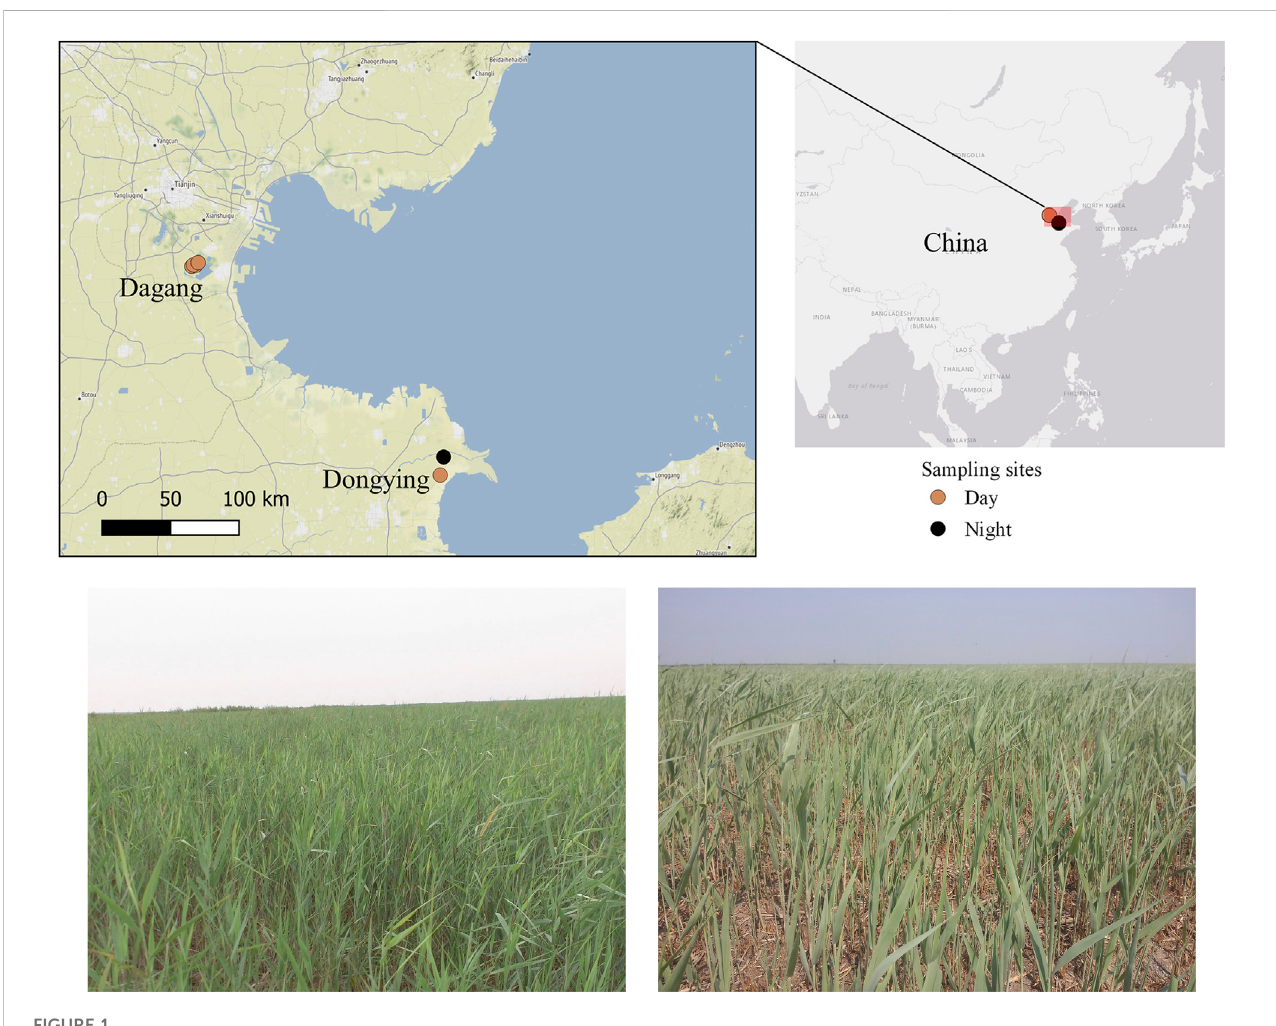
FIGURE 1 Map of study areas (Dagang and Dongying) on the East coast of